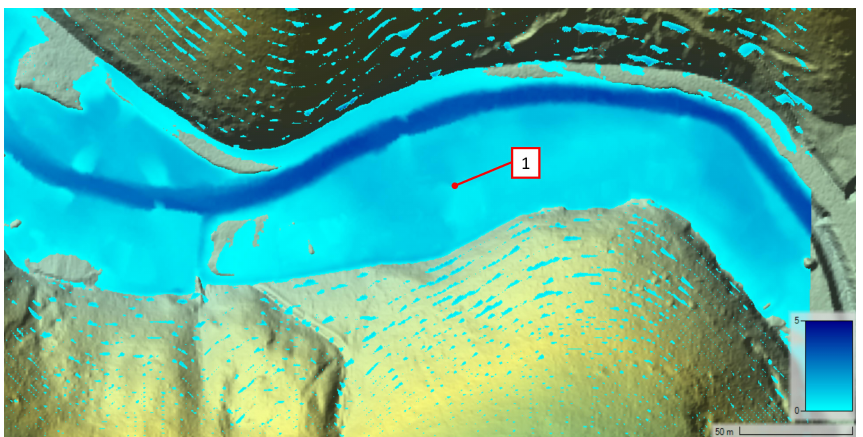
Figure 9. HEC-RAS simulated water depth values using the Digital Elevation Models from the Virginia Lidar dataset. This represents the terrain before the flooding event occurred. The first ground-truth measurement location is marked by the label